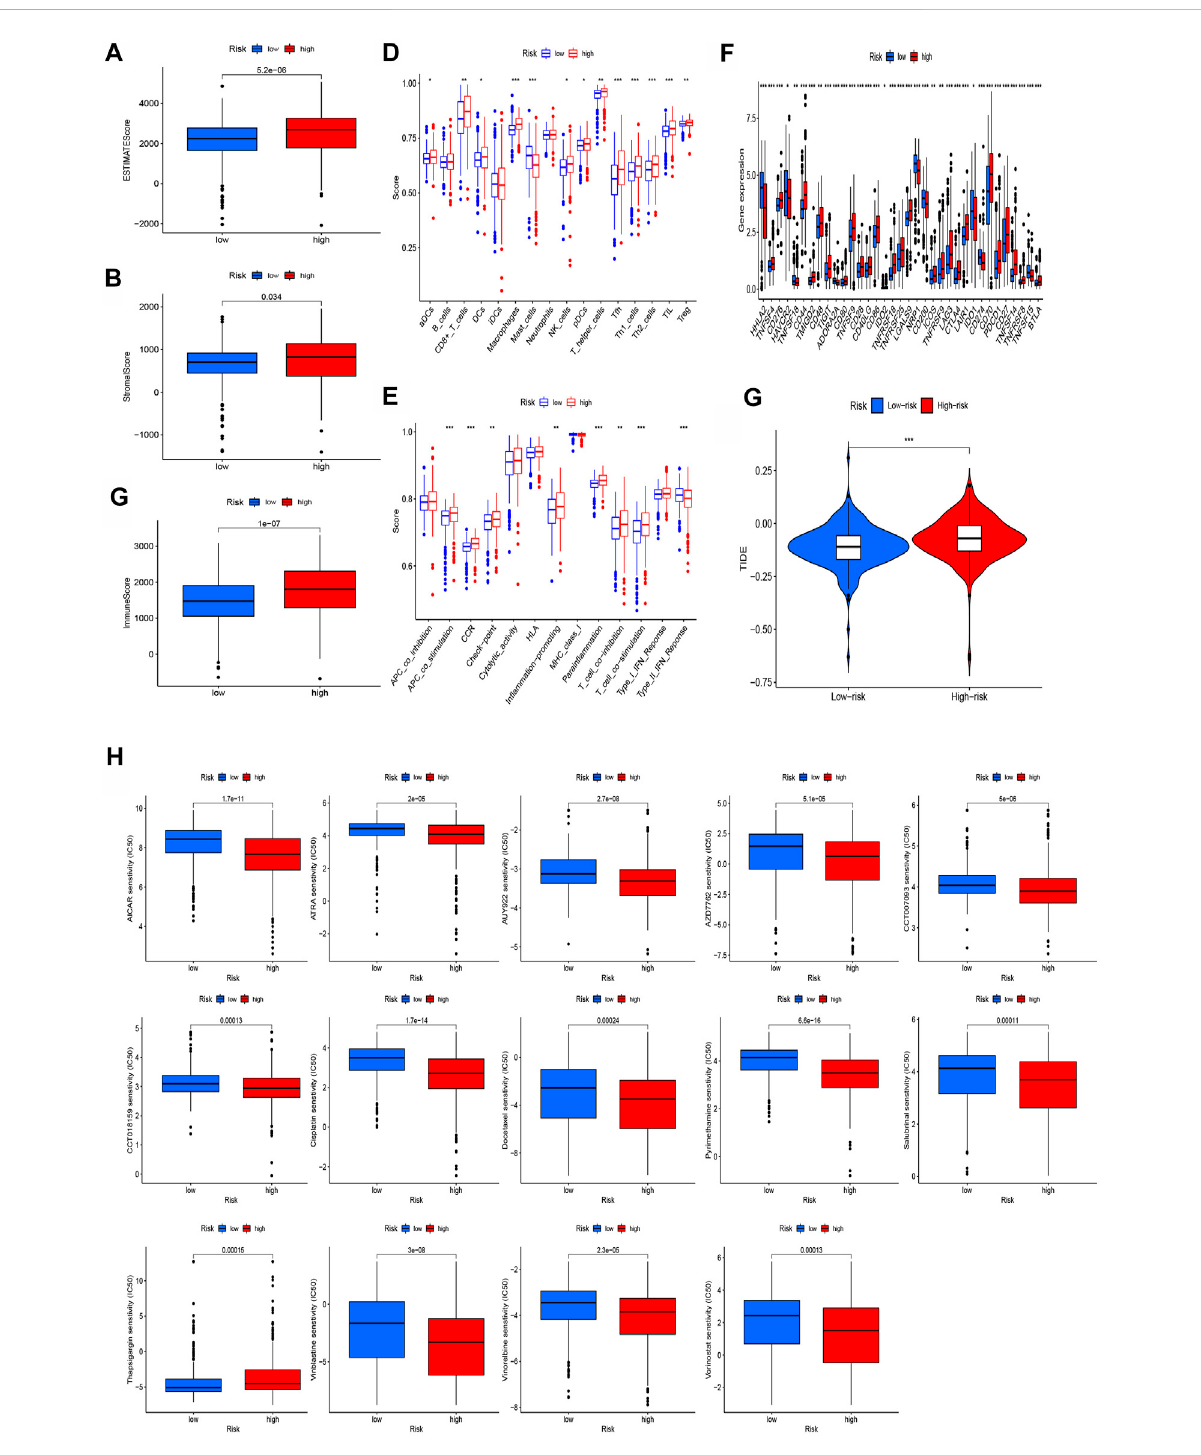
FIGURE 8 Investigation of tumor immune factors and immunotherapy. (A – C) Comparison of ESTIMATE scores, stromal scores, and immune scores between two groups. (D) Comparison of immune cells between two groups. (E) Comparison of immune functions between two groups. (F) Comparison of checkpoints between the two groups. (G) Comparison of TIE between the two groups. (H) Immunotherapy prediction of 14 drugs in high- and low-risk